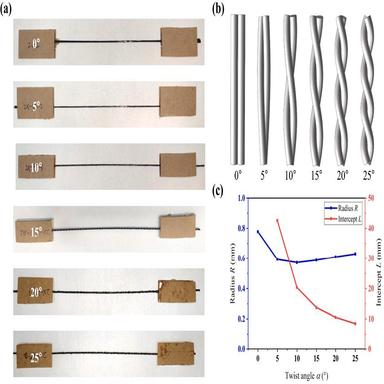
(a) Carbon fiber tows with varying twist angles; (b) Three-dimensional schematic of fiber tows with twist angles ranging from 0◦ to 25◦; (c) Geometric parameters of carbon fiber tows at different twist levels.